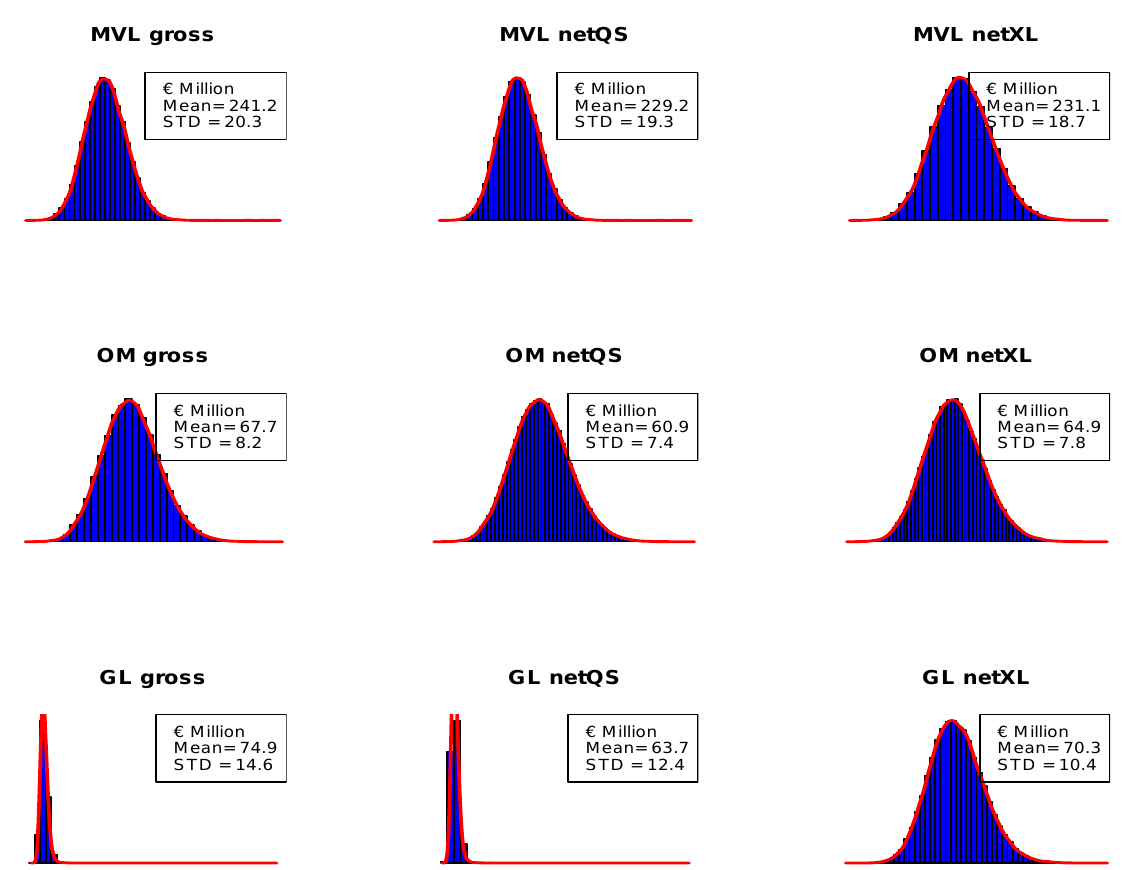
Figure 4. Simulated distributions of Aggregate Claims Cost for Tau (for each Line of Business